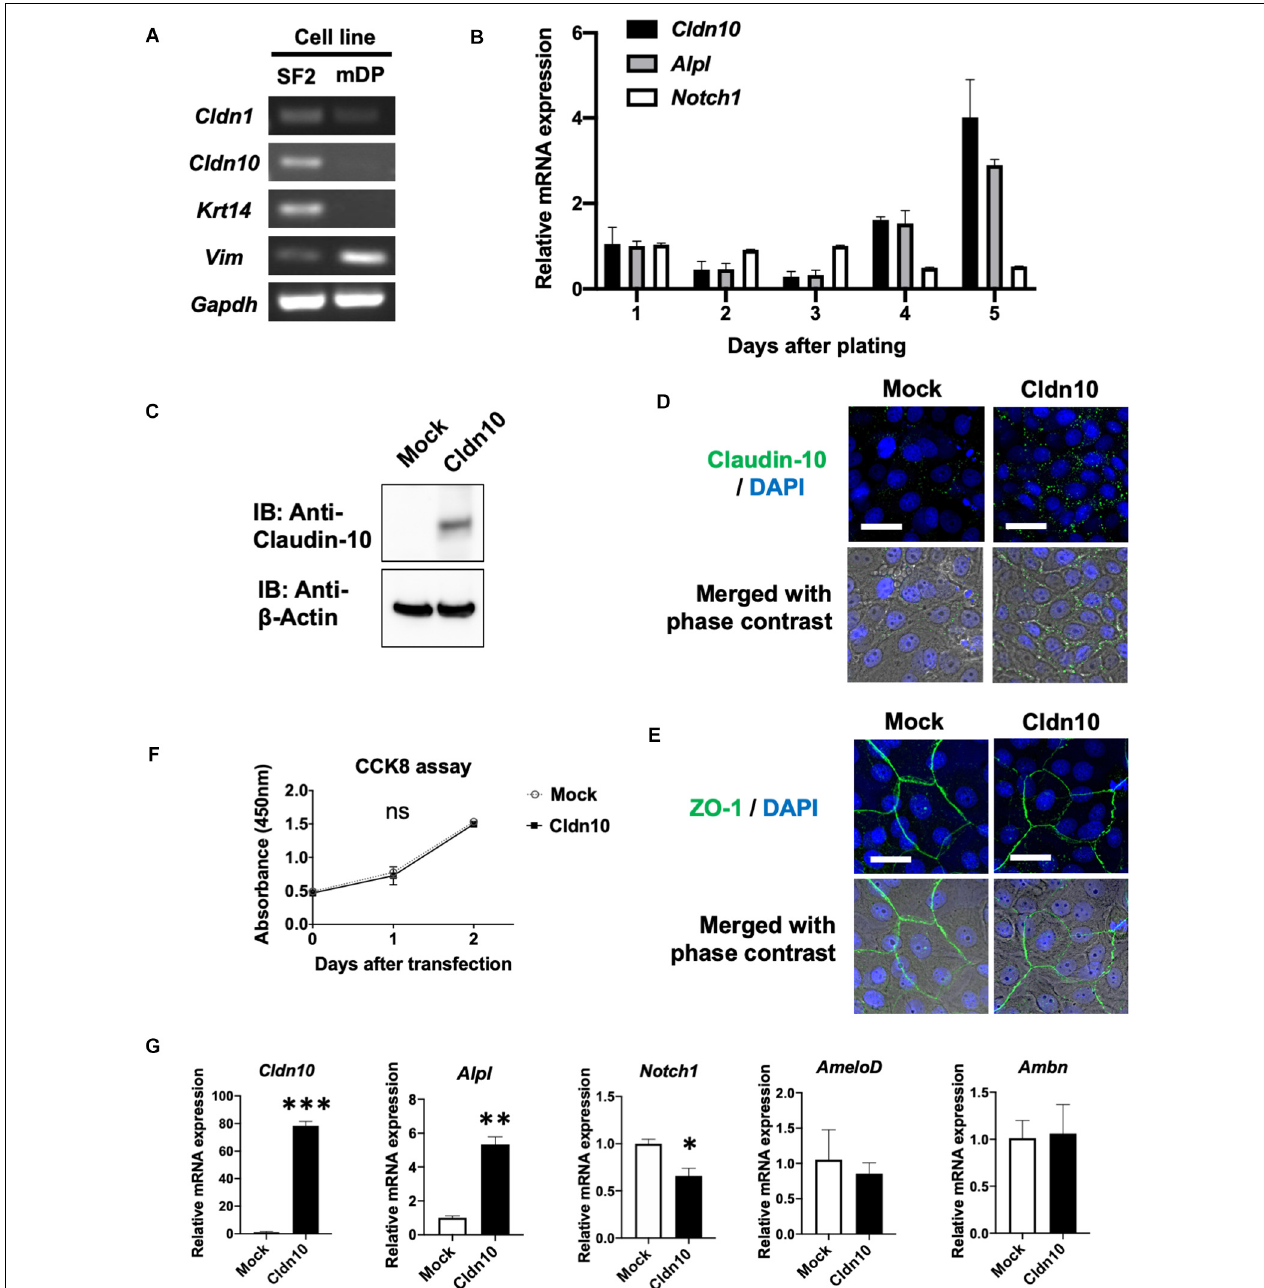
FIGURE 4 | Overexpression of claudin-10b enhances differentiation of rat incisor-derived dental epithelial SF2 cells into the stratum intermedium (SI) cell lineage. (A) Reverse transcription polymerase chain reaction (RT-PCR) analysis of Cldn1 , Cldn10 , Krt14 , and Vim expression in SF2 cells and a mouse dental papilla (mDP) mesenchymal cell line. Krt14 and Vim were used as representative epithelial and mesenchymal marker genes, respectively. (B) Time-course analysis of Cldn10 , Alpl , and Notch1 expression in SF2 cells using quantitative RT-qPCR ( n = 3). Relative mRNA expression was standardized to Gapdh expression. Error bars represent S.D. (C) SF2 cells were transfected with a mock control vector or a Cldn10b expression vector. Western blot analysis showed high expression levels of claudin-10 protein in Cldn10b- overexpressing SF2 cells. (D) Immunofluorescence of Claudin-10 in mock-transfected and Cldn10b- overexpressing SF2 cells. Upper panel: Green, claudin-10; blue, DAPI. Lower panel: merged image with phase contrast from upper panel. Scale bars, 10 µ m. (E) Immunofluorescence of ZO-1 in mock-transfected and Cldn10b- overexpressing SF2 cells. Upper panel: Green, ZO-1; blue, DAPI. Lower panel: merged image with phase contrast from upper panel. Scale bars, 10 µ m. (F) Cell Counting Kit-8 (CCK-8) assay of mock-transfected and Cldn10b -transfected cells revealed similar proliferation rates ( n = 3). Error bars represent S.D. ns (not significant), p > 0.05 with two-way ANOVA. (G) Expression of Alpl , Notch1 , AmeloD, and Ambn in Cldn10b -overexpressing SF2 cells ( n = 3). Error bars represent S.D. ∗ p < 0.05; ∗∗ p < 0.01; ∗∗∗ p < 0.001 with two-tailed t -test.